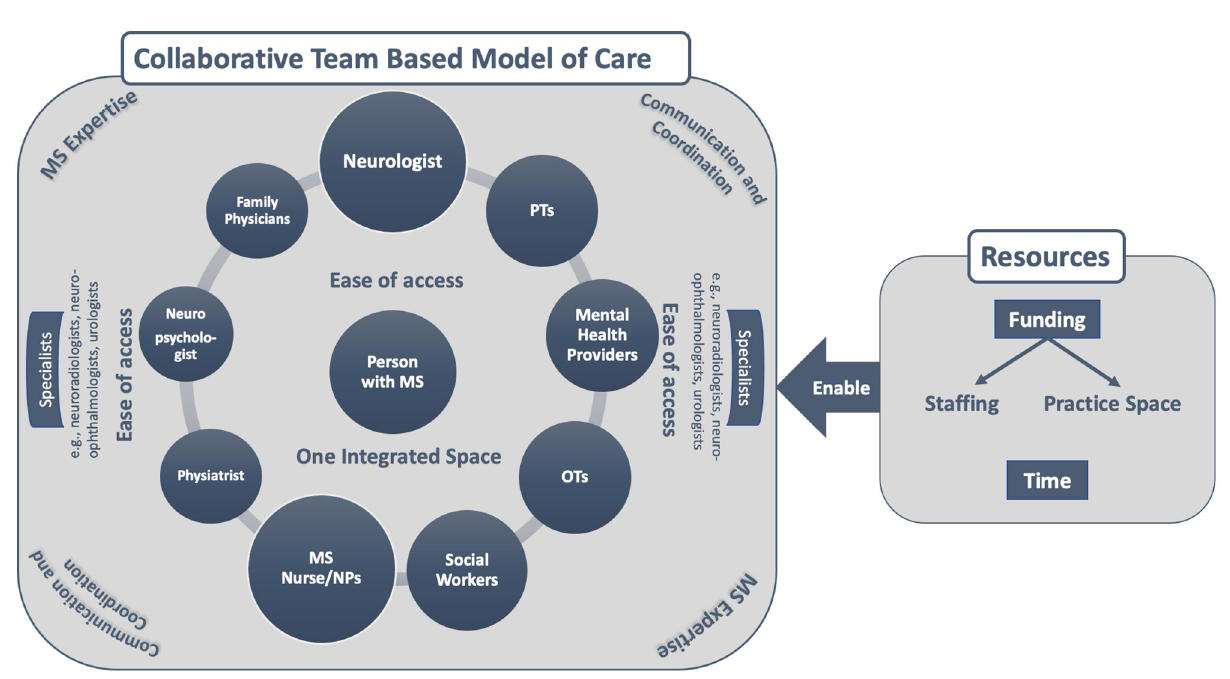
FIGURE1 A conceptual depiction of what multiple sclerosis (MS) care should look like according to Canadian Healthcare Providers working with persons with MS as well as the resources required to enable this standard of care. People living with MS, neurologists and nurses play a key role in disease treatment (largest bubbles), but in order to comprehensively manage MS the need for timely access to PTs, OTs, mental health providers and social workers (next largest bubbles) was emphasized. Access to information sharing, smooth referrals, and providers with expertise in MS were highlighted for physiatrists, neuropsychologists, and family physicians. Improved access, communication, and coordination between the team and specialists (neuroradiologists, neuro-ophthalmologists, and urologists) with a level of expertise in MS was also